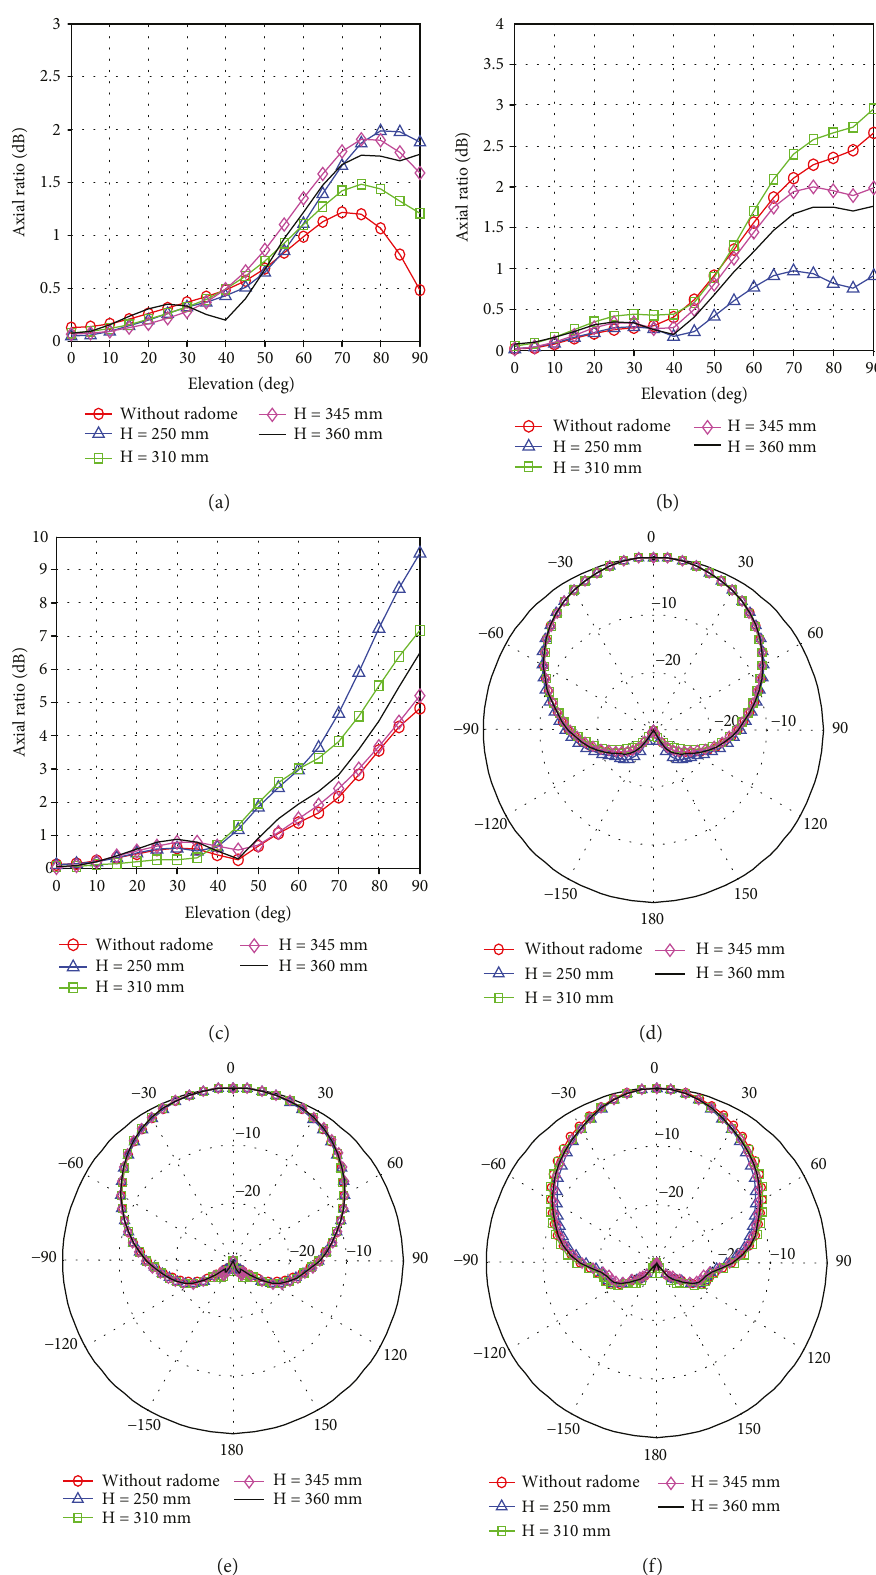
Figure 5: Simulated radiation characteristic comparison of antennas with di ff erent heights of radome: maximum axial ratio versus the elevation angle (a) at 1.22 GHz, (b) at 1.58GHz, and (c) at 2.5GHz; E-plane radiation pattern (co-pol) (d) at 1.22GHz, (e) at 1.58GHz, and (f) at